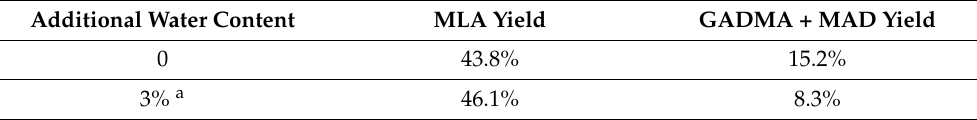
Table 2. Catalytic conversion of HFCS-55 with additional water.